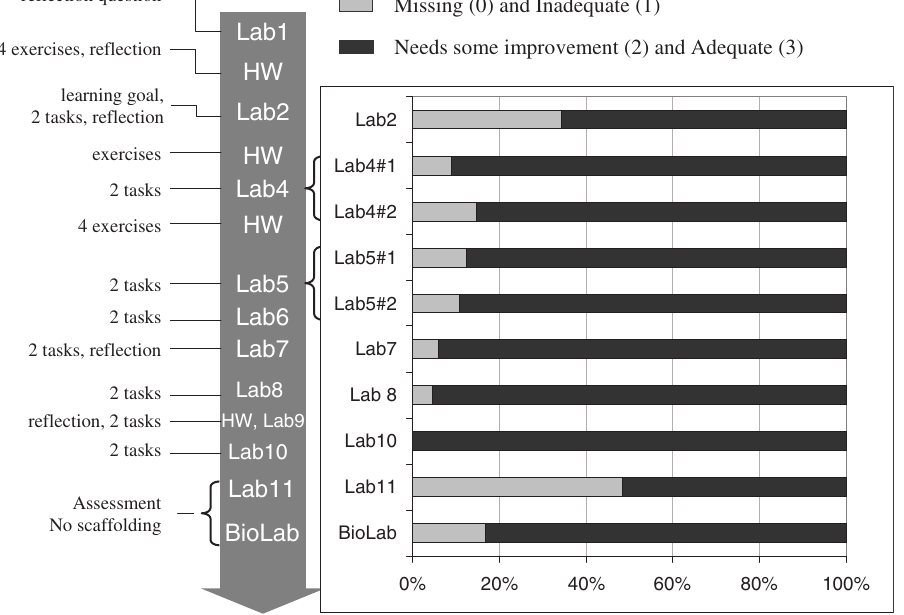
FIG. 2. Ability to identify ex- perimental uncertainty. Laborato- ries 4 and 5 had two experiments each, which were scored sepa- rately. The arrow on the left shows activities related to this ability in laboratories and homework. The shaded bars represent the percent- age of the students whose labora- tory reports received missing and inadequate and need some im- provement and adequate.